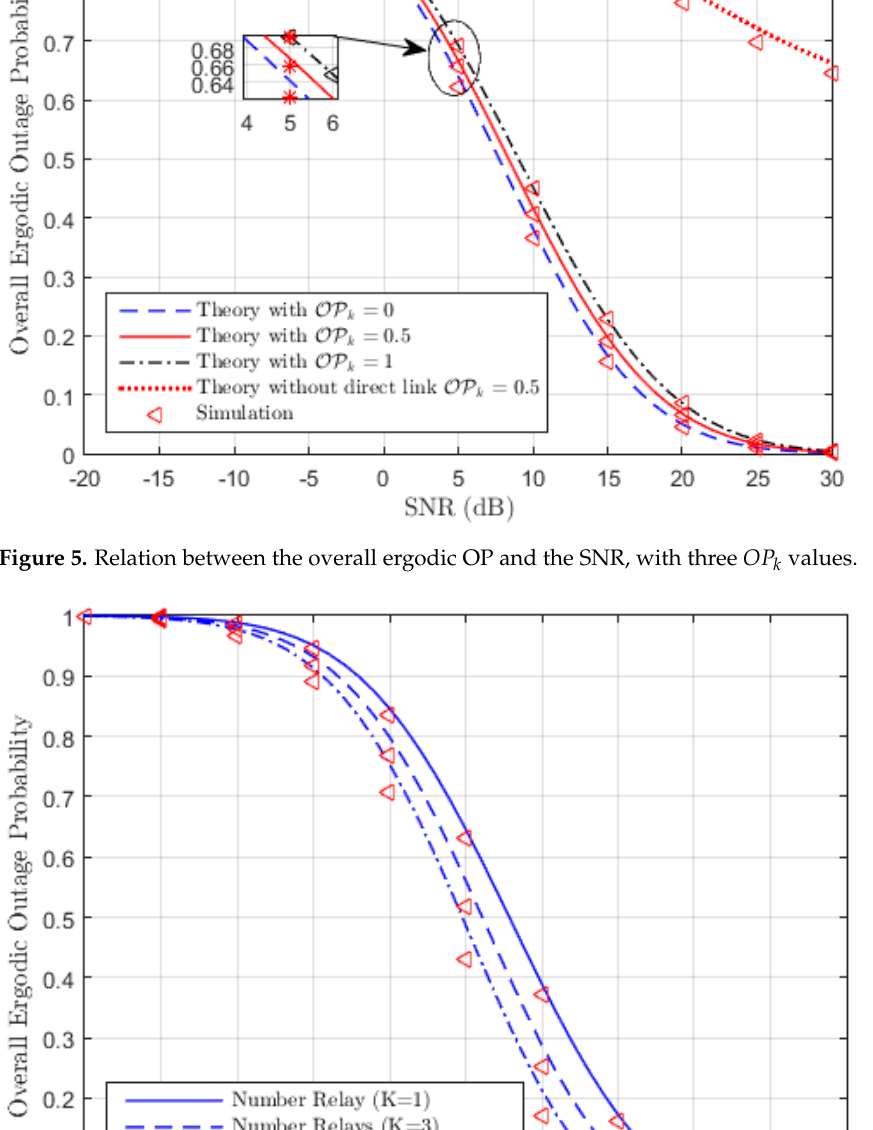
Figure 5. Relation between the overall ergodic OP and the SNR, with three 𝑂𝑃 (cid:3038) values.